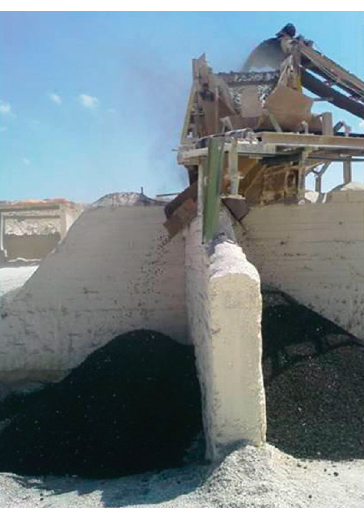
Figure 1: Crushing and screening of slag